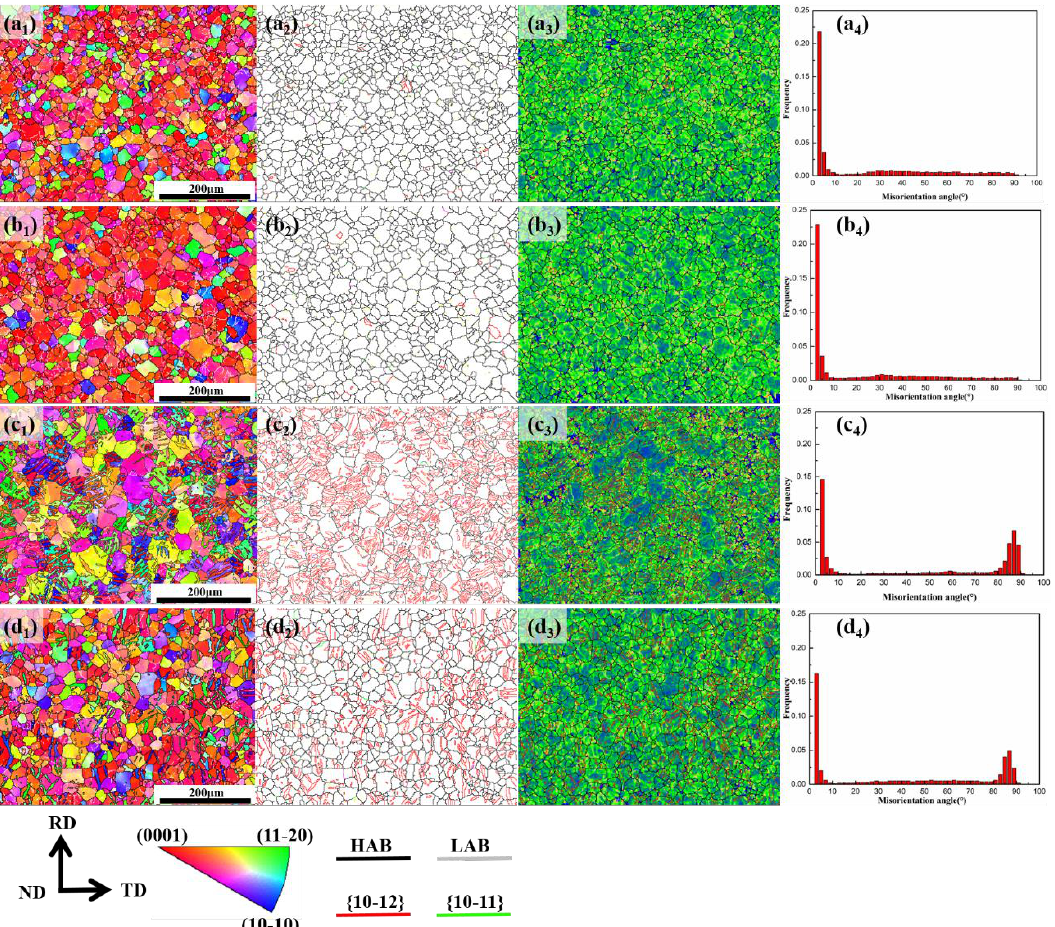
Figure 2. Electron back-scatter diffraction (EBSD) results from the different samples without annealing: ( a ) upper surface of HTR sample; ( b ) mid-layer of HTR sample; ( c ) upper surface of HTR-CB sample; ( d ) mid-layer of HTR-CB sample, including inverse pole figure maps, boundary misorientation maps, kernel average misorientation maps and misorientation angle distributions.